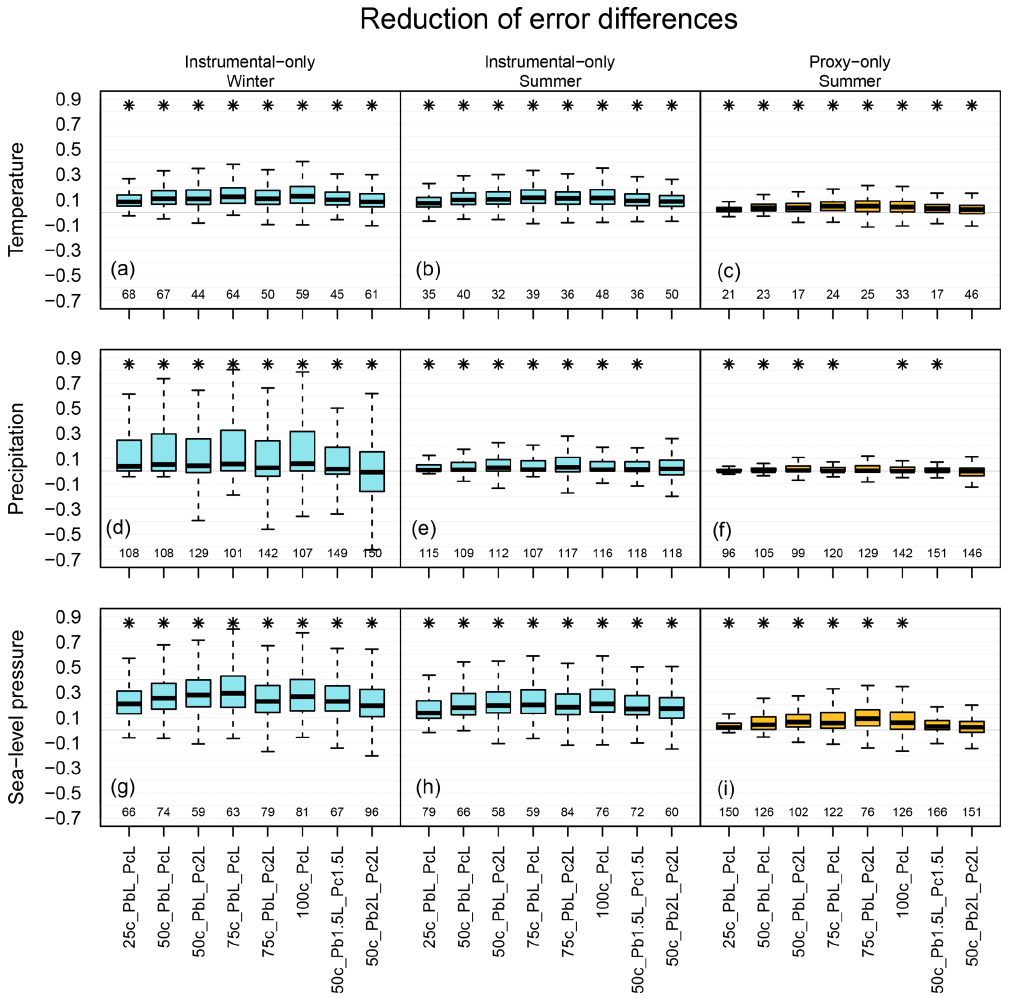
Figure 6. Distribution of RE value differences between the mixed background-error covariance matrix experiments and the original setup over the ENH region; otherwise, it is the same as in Fig.